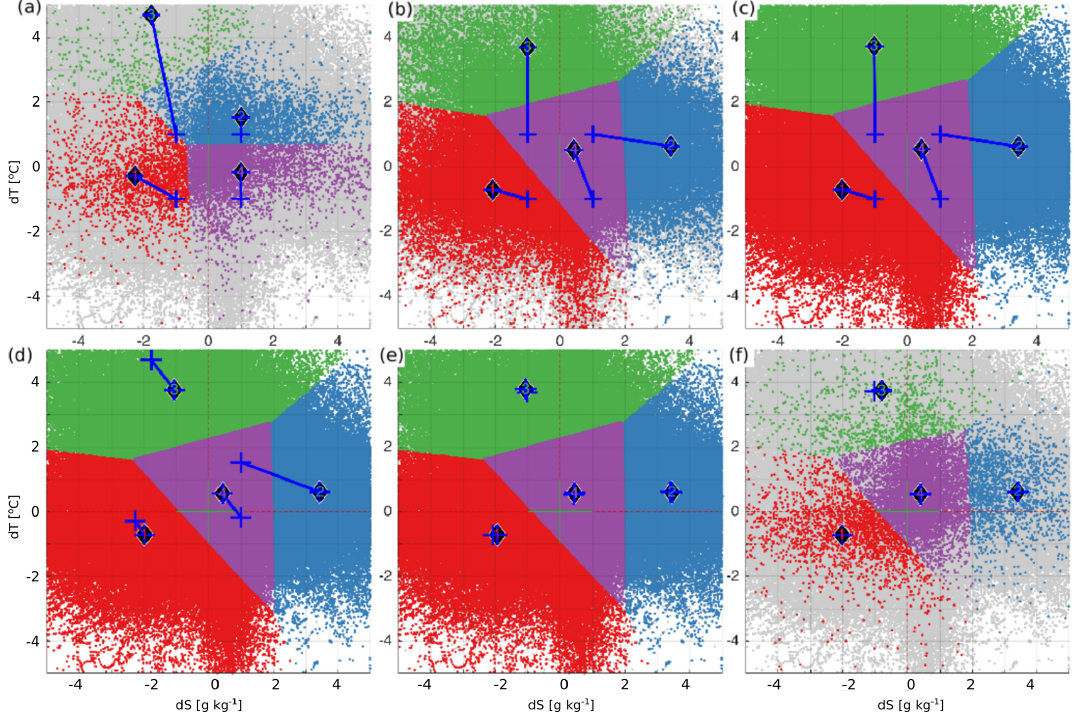
Figure 7. Learning (a–c) and predicting (d–f) of the K = 4 clusters. The learning and predicting datasets have a share of 1% (a) and 99% (d) , 20% (b) and 80% (e) , and 99% (c) and 1% (f) of the full dataset, respectively. Blue crosses mark the location of initial centroids and blue lines connect initial and final locations (marked with numbered diamonds) of the centroids.